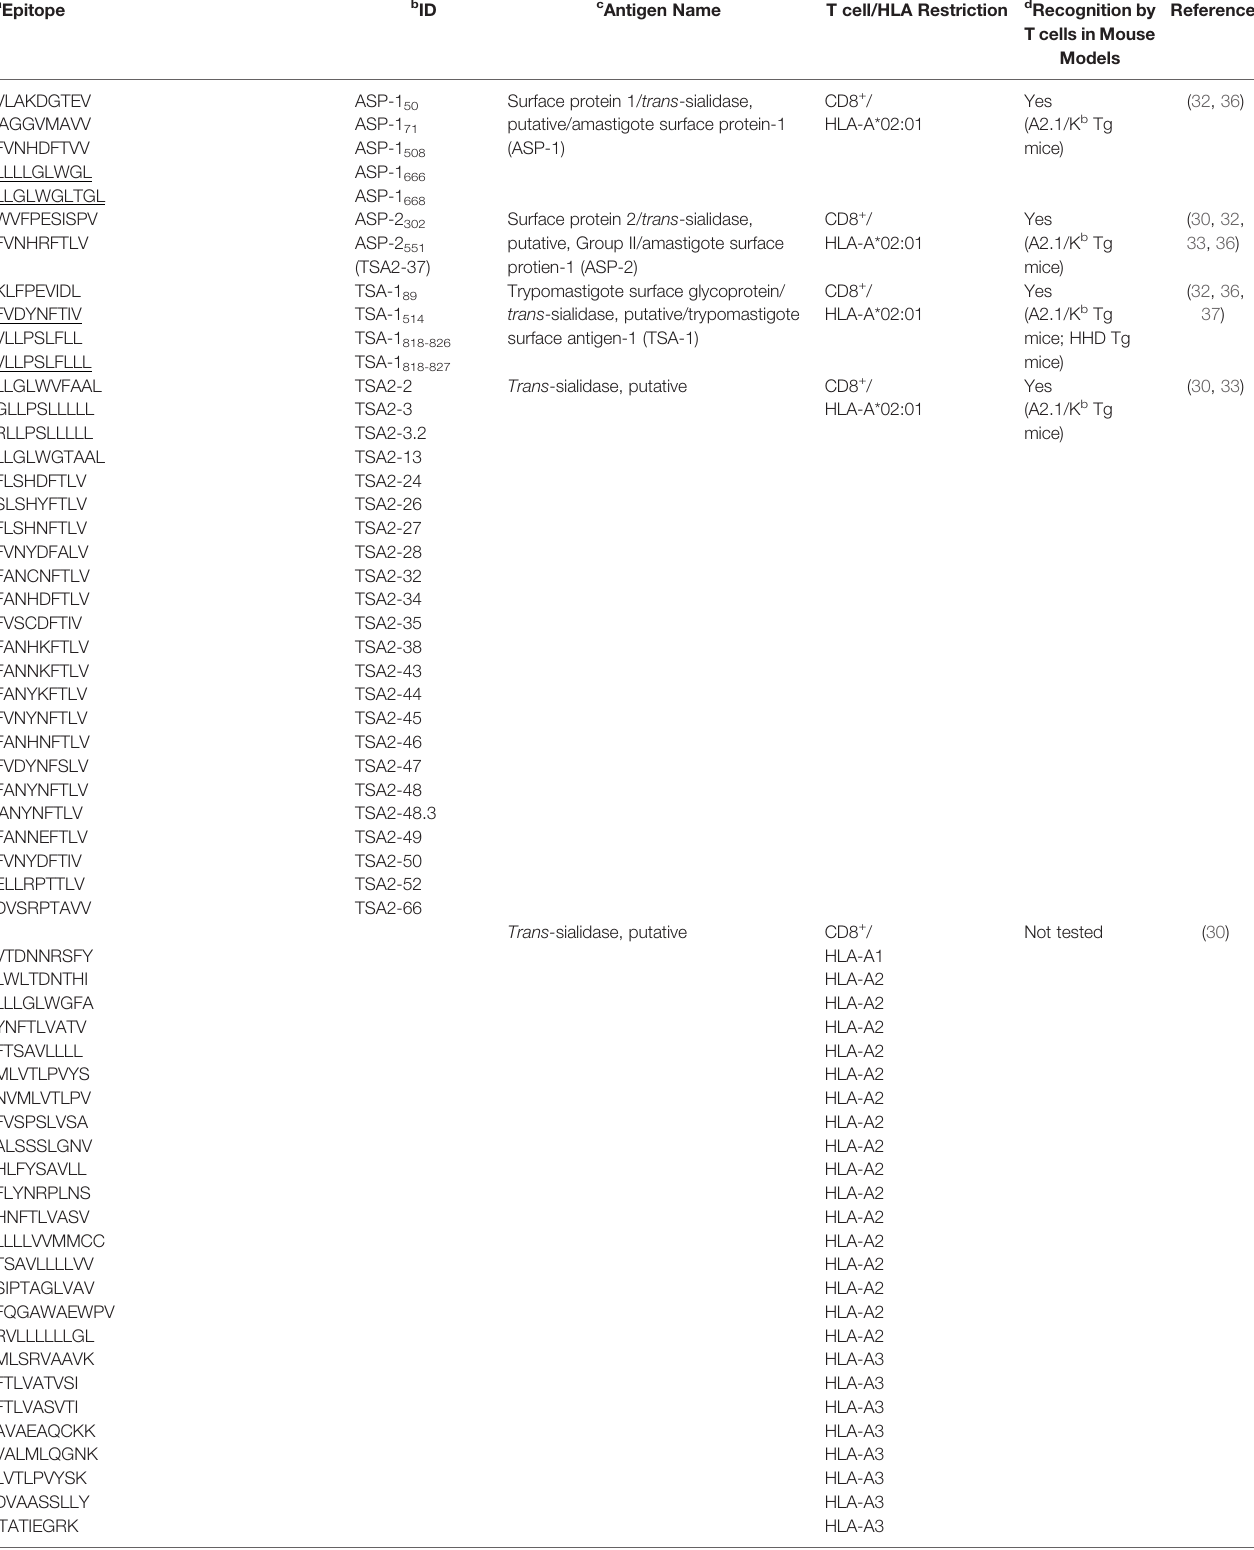
TABLE 1 | T. cruzi epitopes recognized by T cells from Chagas disease